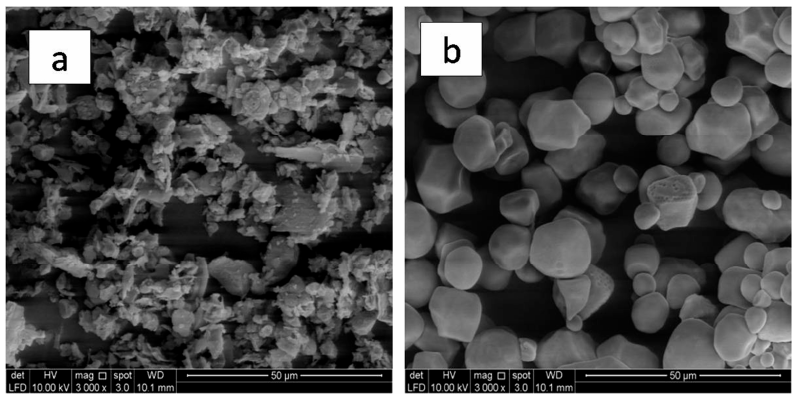
Figure 5. Surface morphology of ( a ) irregular TPRH granules and ( b ) spherical TPS granules.